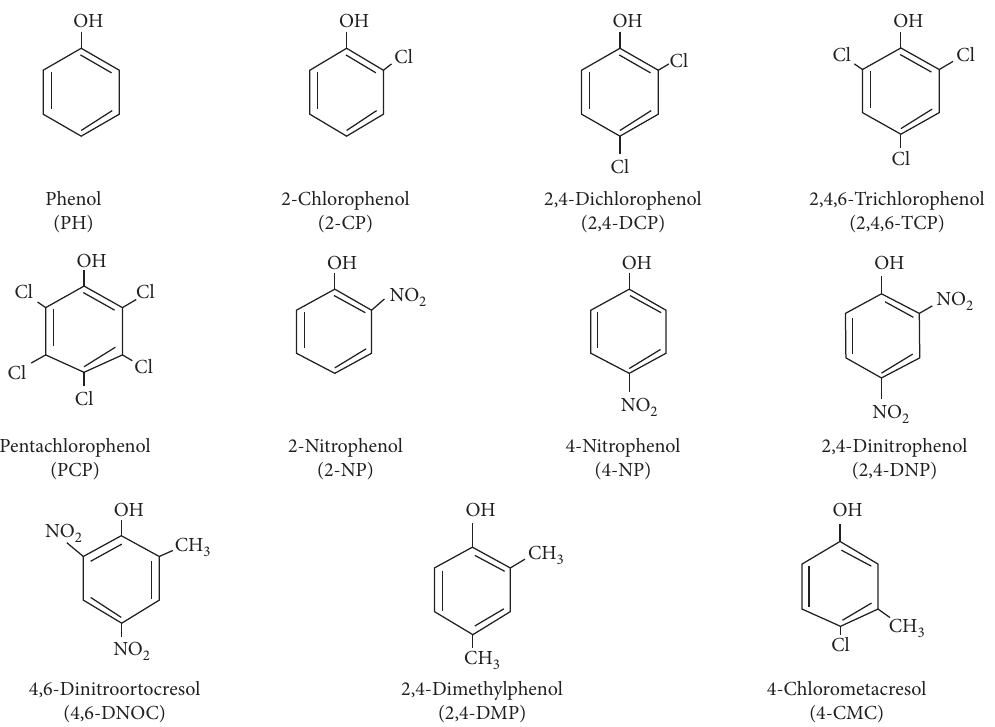
Figure 1: Phenolic compounds structures considered priority contaminants by US EPA